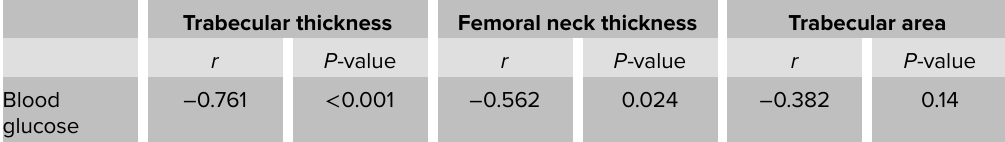
TABLE 3: Correlation analysis between histomorphometric parameters and blood glucose